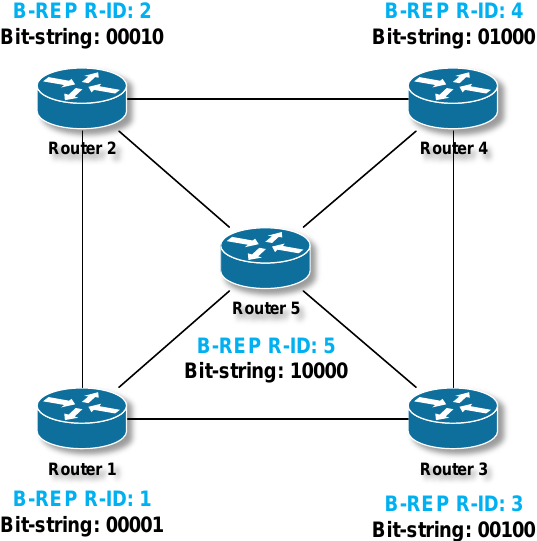
Figure 7. Allocation of Bit-String position according to the B-REP Router ID.